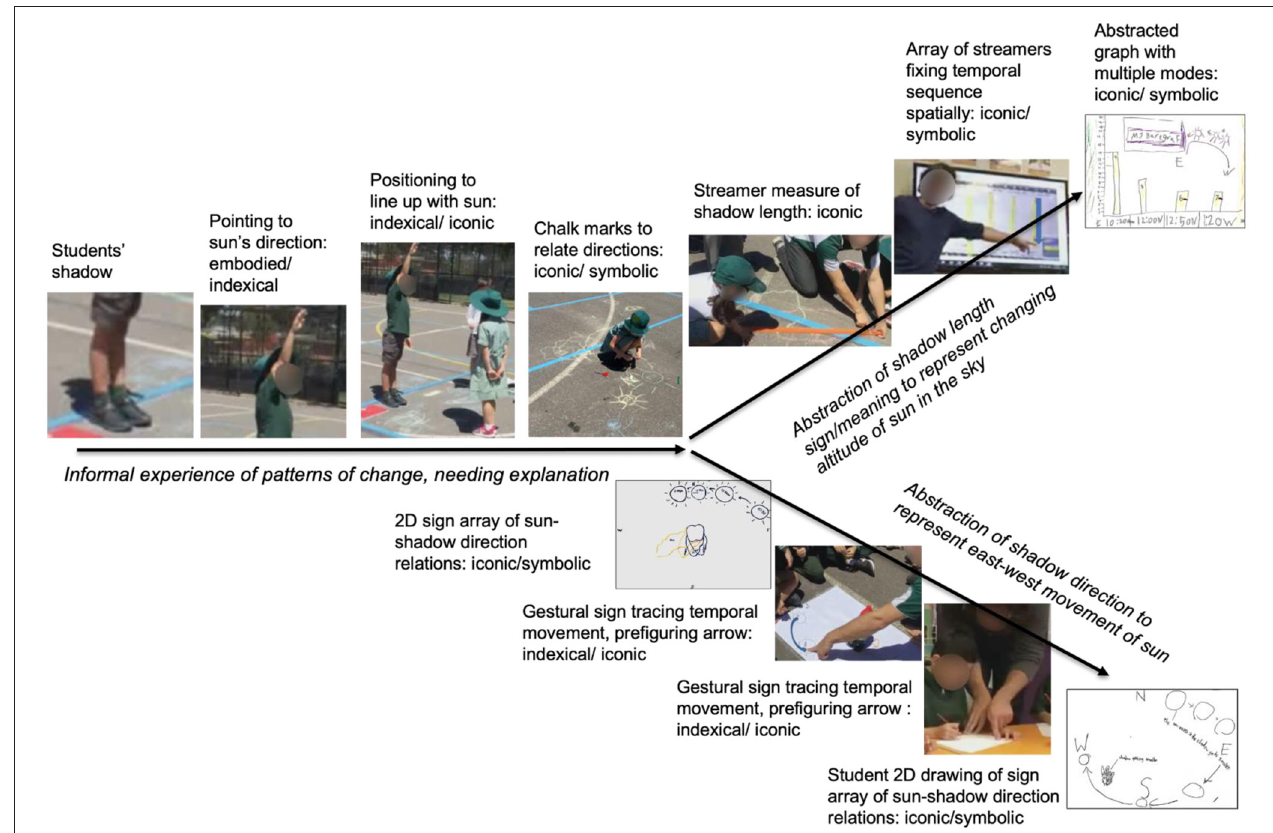
FIGURE 13 | Sequence of teacher and student sign-making to support students’ successive transductions of shadow-sun